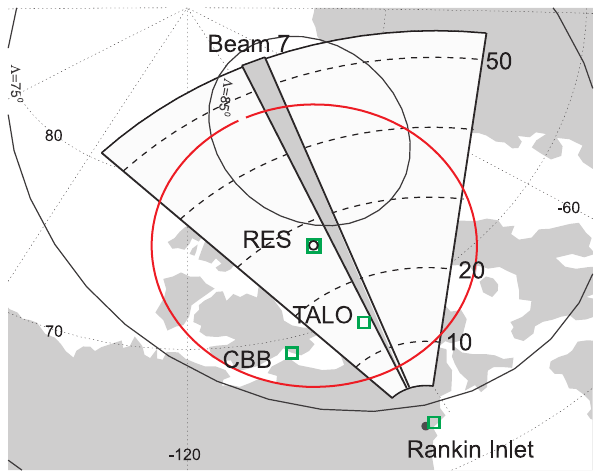
Fig. 1. Field of view (FoV) of the Rankin Inlet (RANK) Polar- DARN radar between ranges of 400 and 2600km and location of ground-based magnetometers data from which are used in the study. The dashed lines indicate radar ranges according to the gate number (10, 20, 30, 40, 50). A shaded beam-like area within the radar FoV is the position of beam 7. Red circle represents the FoV of all-sky camera (for the off-zenith angles of < 75 ◦ ) at Resolute Bay (RES) for the height of